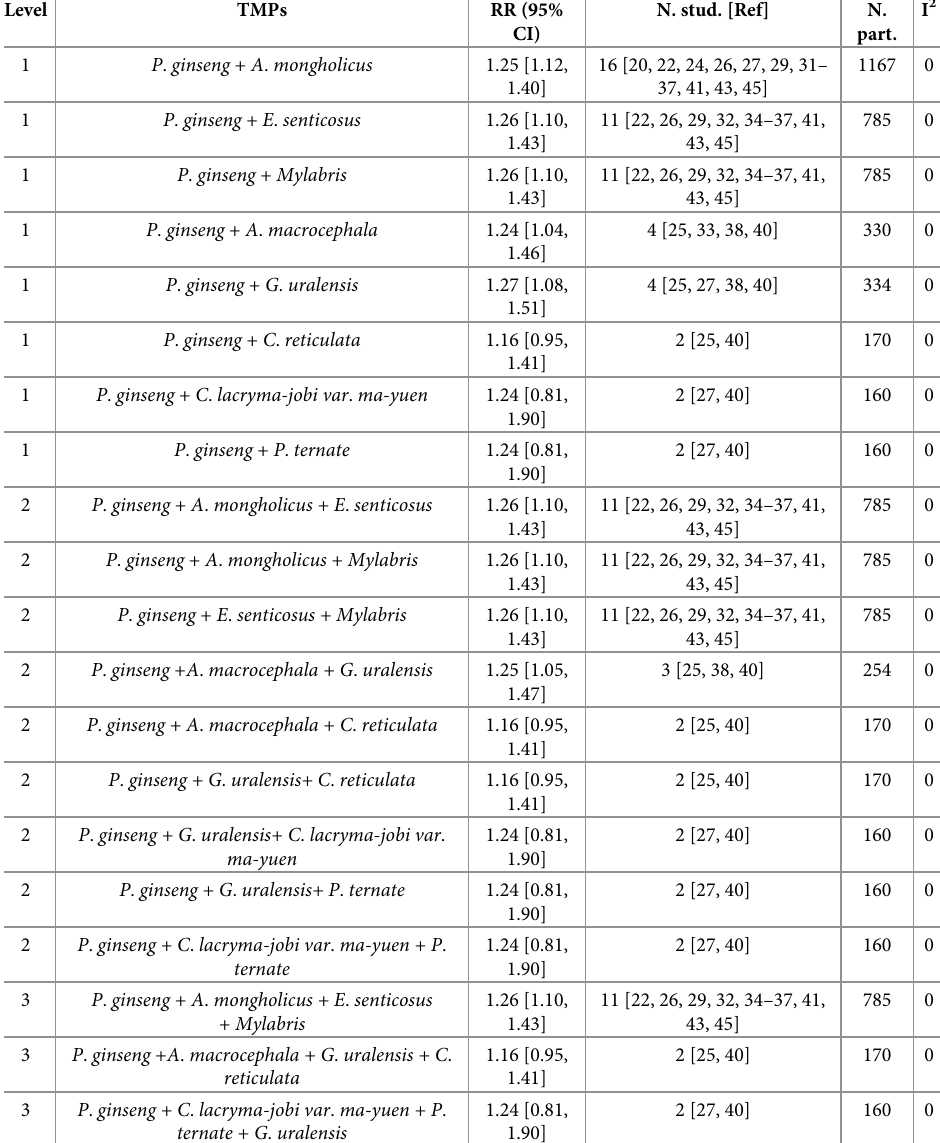
Table 5. Effects of specific G-TMPs on ORR for AGC: Combination of Ginseng and other herbs. Level TMPs RR (95%